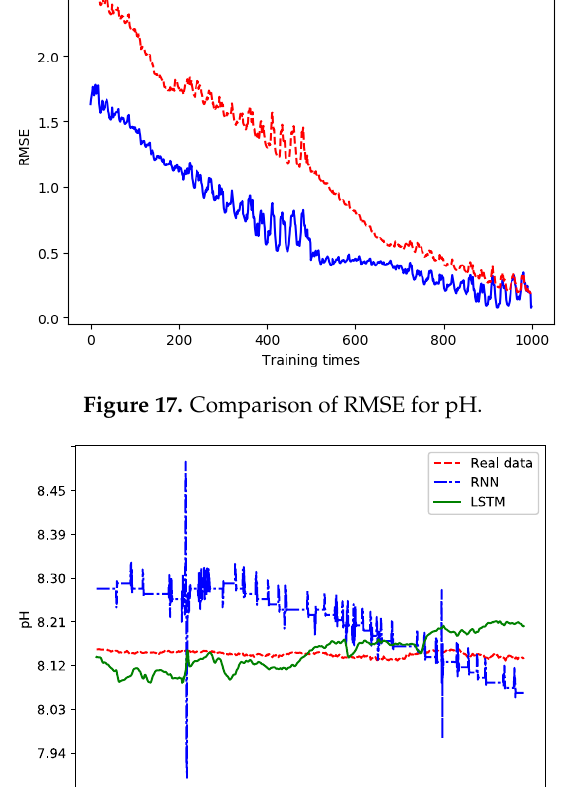
Figure 18. Comparison of the long ‐ term prediction effect for pH.